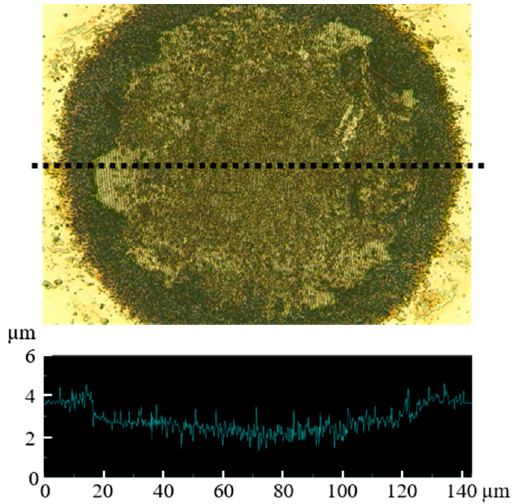
Figure 10. Topography of craters with N = 500 pulses at F = 0.04 J/cm 2 under air.